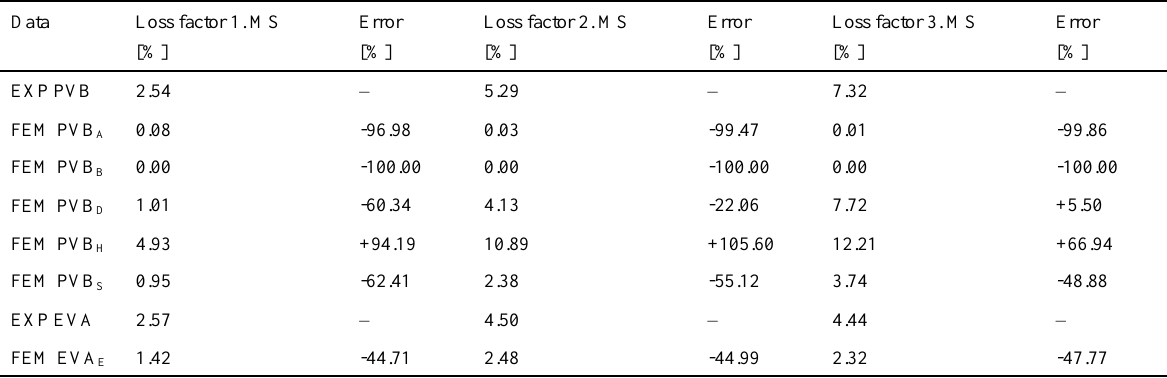
Table 4: Modal analysis: Comparison of experimental data and numerical predictions of loss factors for the first three mode shapes (MS).